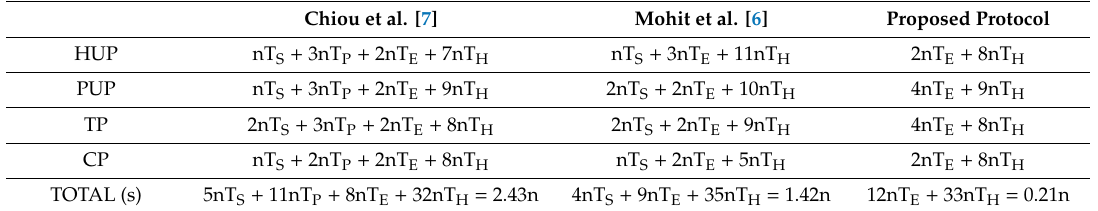
Table 5. Computational cost of protocols.